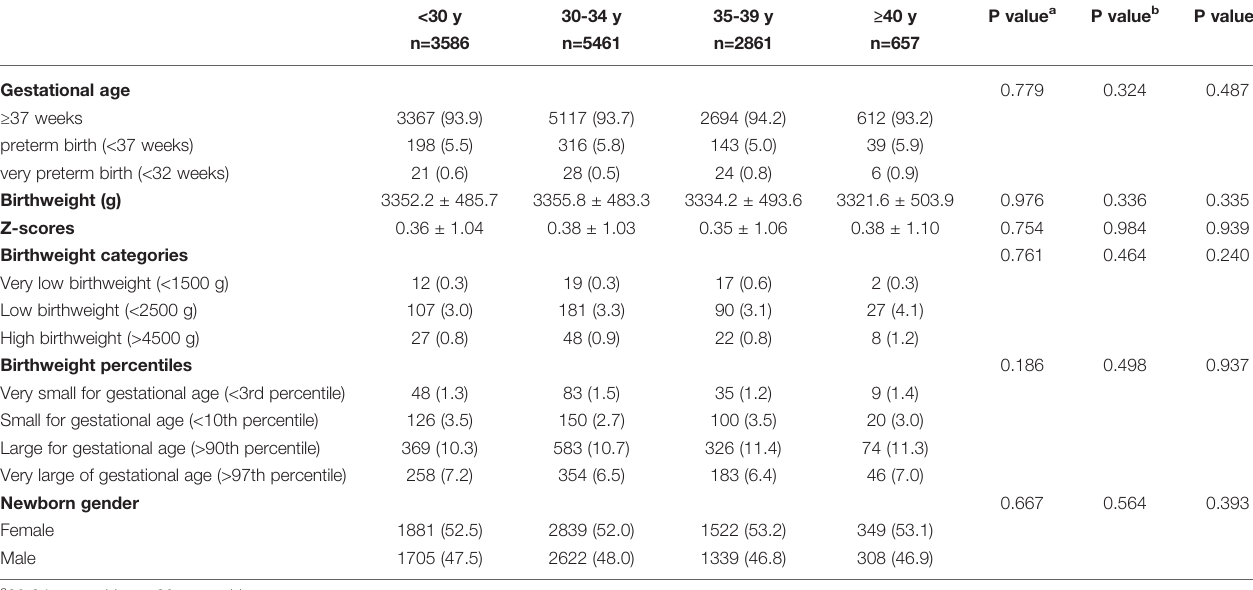
TABLE 2 | Neonatal outcomes of live born singletons by maternal age.